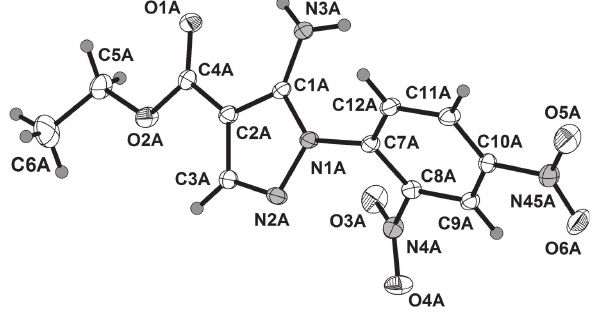
Table 1: Data collection and handling.